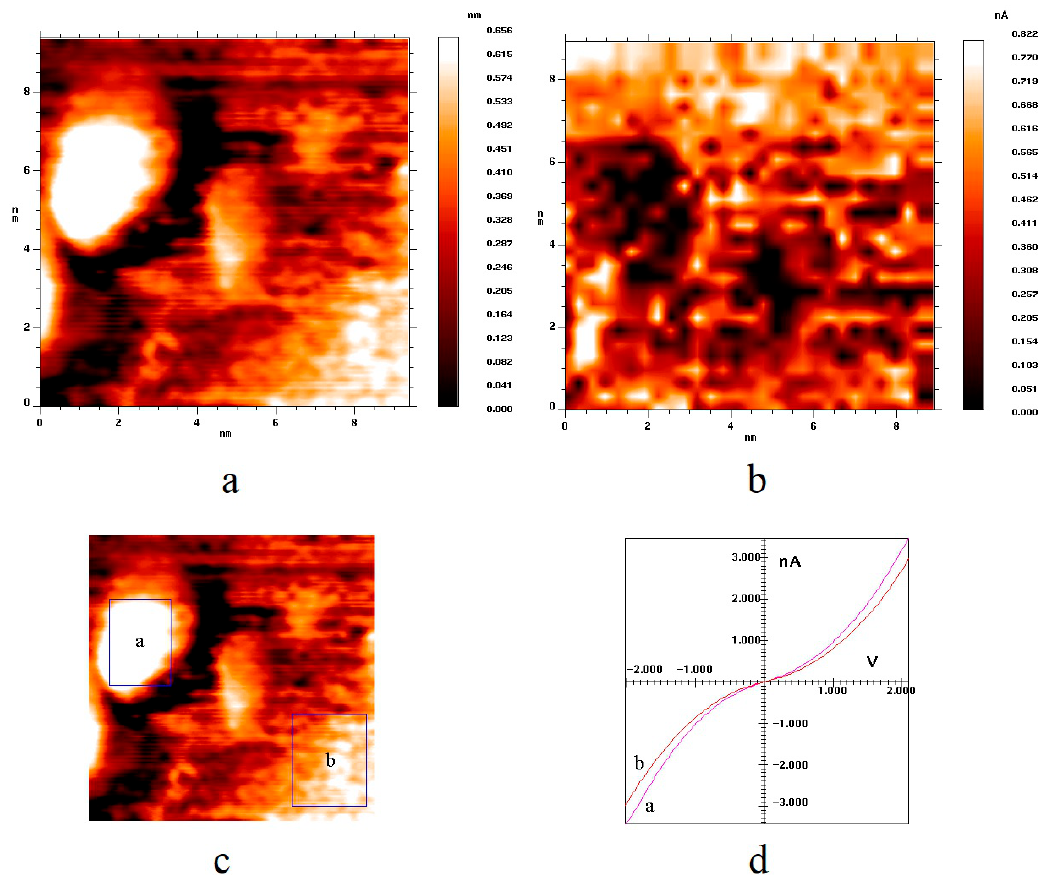
Figure 2. ( a , c ) Topography images of HOPG surface area containing a gold nanoparticle; ( b ) current image of the same surface area; ( d ) volt–ampere characteristic (VAC) of the tunneling currents, averaged over the surface areas indicated by the rectangles in Figure 2c. U bias = 2.1 V, I tunnel = 2.9 nA.